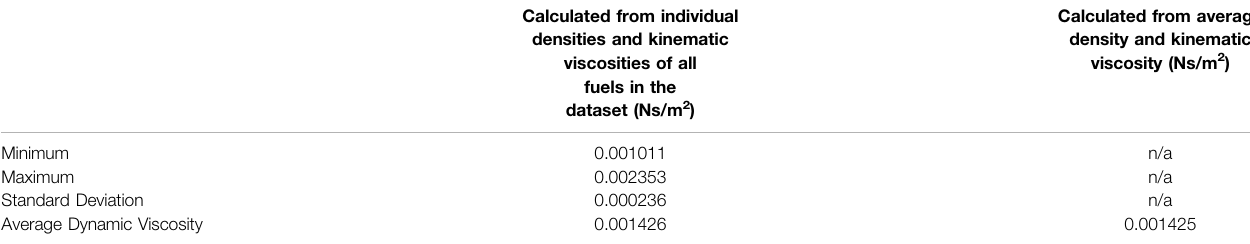
TABLE 2 | Example of error introduced by calculations based on average values from property